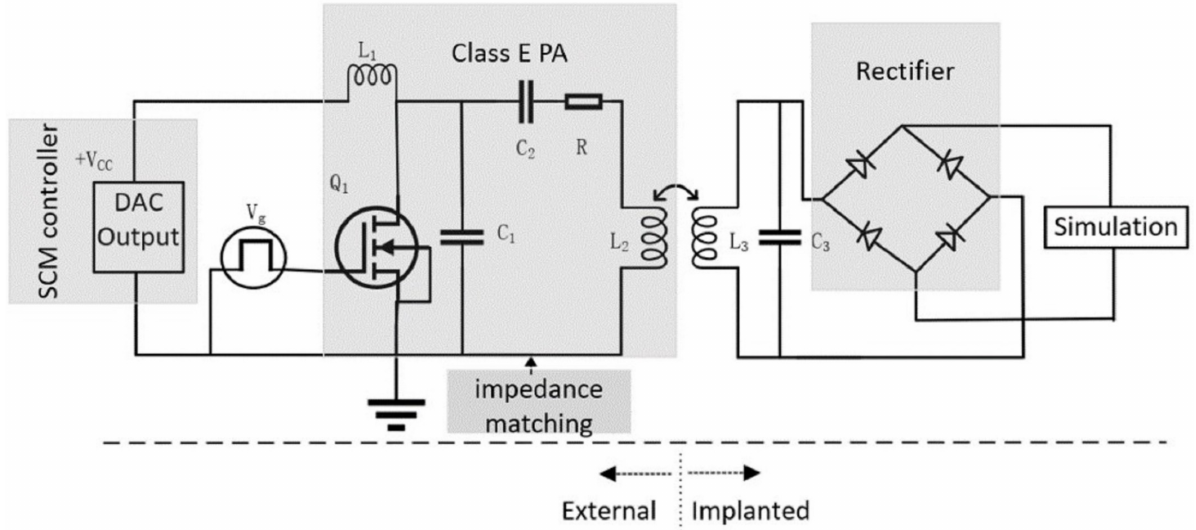
Figure 2. The system overview of the wireless stimulation